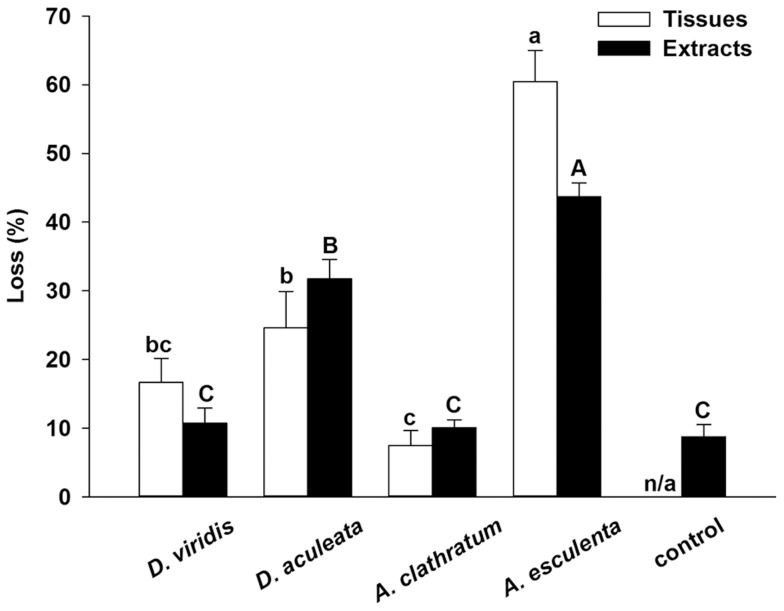
Loss in mean (+SE) wet weight as a percentage of initial wet weight of tissues (Experiment 1) and agar-embedded extracts (Experiment 2) of Desmarestia viridis, Desmarestia aculeata, Agarum clathratum, and Alaria esculenta sporophytes exposed 48 h to grazing by 10 green sea urchins, Strongylocentrotus droebachiensis.Bars not sharing the same letter are different (LS means tests, p<0.05; n = 15 [Experiment 1] and 20 [Experiment 2]) (see “Materials and methods” for a description of each experiment and nature of the procedural control in Experiment 2).